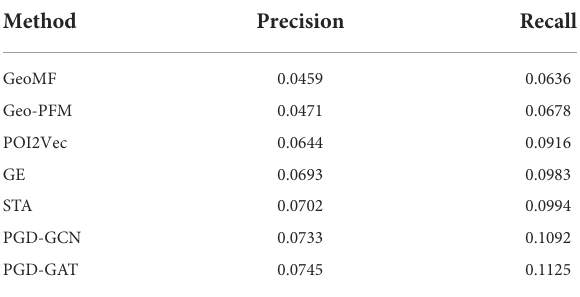
TABLE 9 Results of variants on Foursquare.